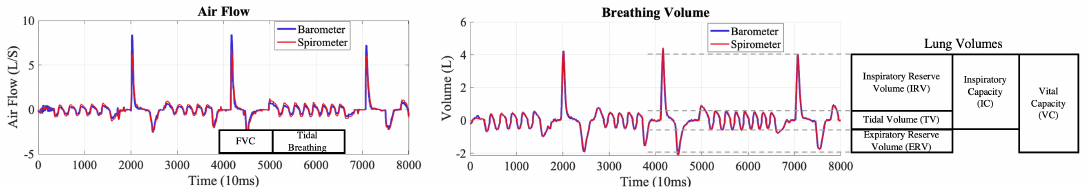
Figure 2. Flow-volume loop of a FVC maneuver from Participant 1.